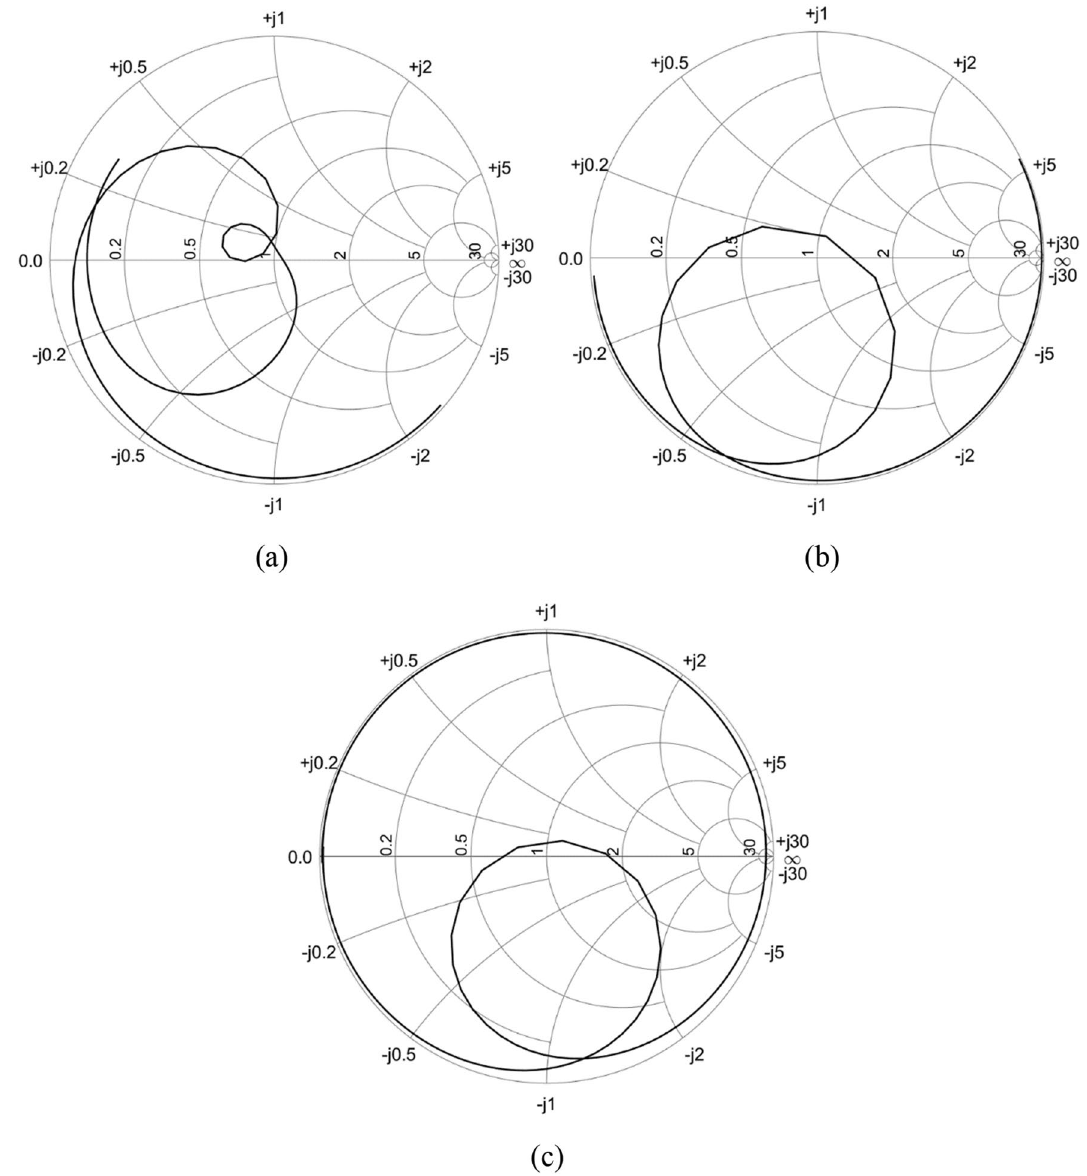
Figure 3. Input impedance at Smith chart: ( a ) Yagi antenna, ( b ) Patch antenna and ( c ) Antenna